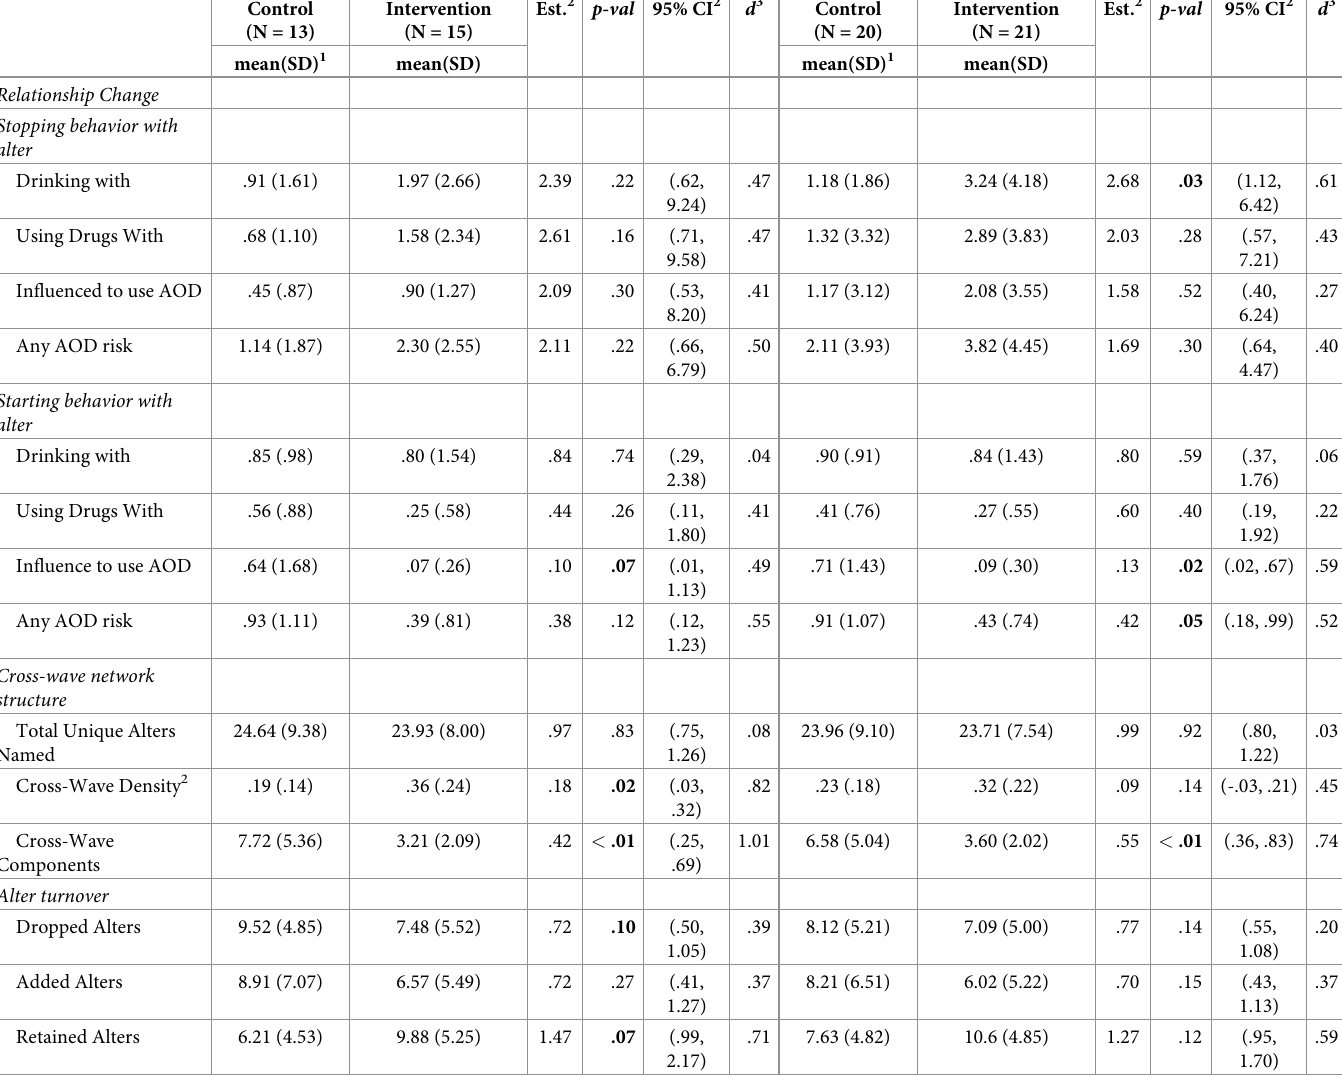
Table 2. a. Regression model results for intervention effects on relationship change count outcomes, network structure, and network turnover, SRHT only (N = 28). b. Regression model results for intervention effects on relationship change count outcomes, network structure, and network turnover, full sample (N =